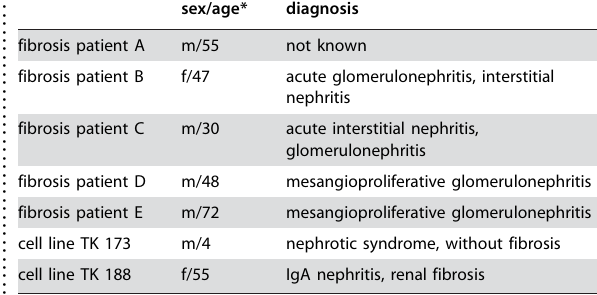
Table 1. Histopathologies of fibrosis patients and